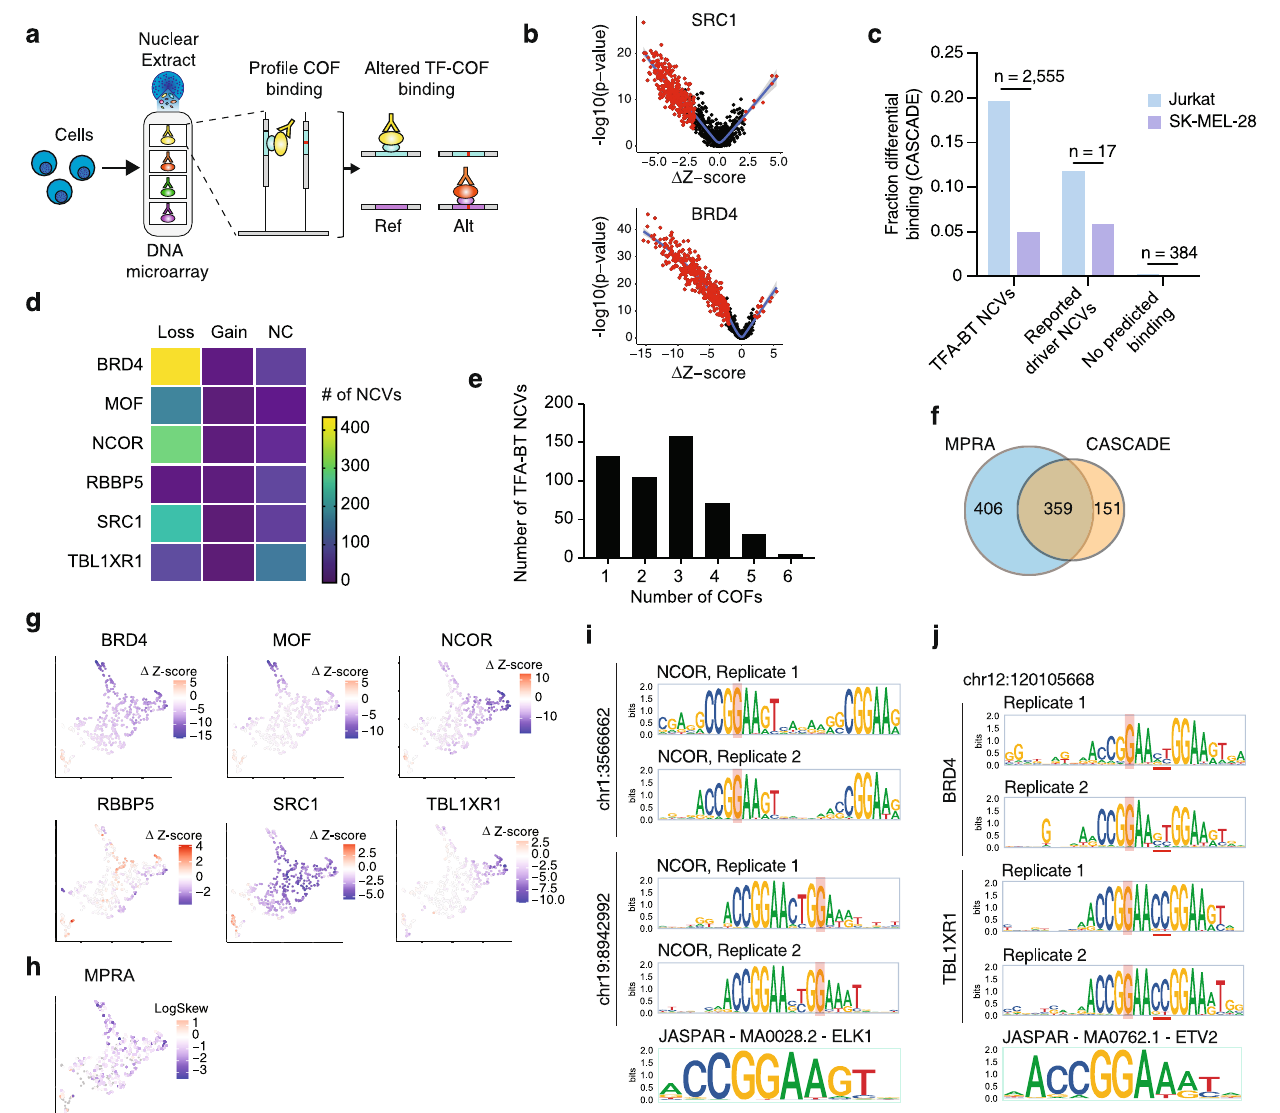
Fig. 3 | Pro fi ling TF-COF complex binding altered by NCVs. a Overview of the CASCADE method to pro fi le TF-COF complex binding affected by NCVs (Ref - referenceandAlt-alternativealleles). b ImpactofTFA-BTNCVsontherecruitment of SRC1 and BRD4 to 2555 Ref/Alt NCV probes sets assayed using Jurkat T-cell nuclear extracts. Impact is quanti fi ed using -log 10 (p-value) of the COF recruitment to the different probesets and the difference in PBM-determined Z-score between Ref and Alt alleles ( Δ z-score). P values are calculated using two-sided Student ’ s t-test comparing fi ve replicates of Ref and Alt alleles. The NCVs identi fi ed as sig- ni fi cant are highlighted in red. c Fraction of NCVs from different probe sets iden- ti fi ed assigni fi cant by CASCADE in Jurkat and SK-MEL-28 cells. Numbers at the top